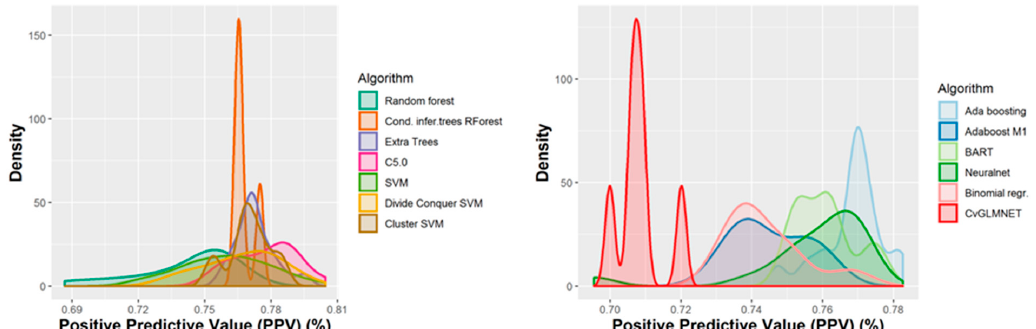
Figure 5. Performance of the 165 QSAR models in terms of positive predictive value.